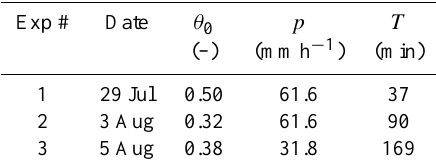
Table 2. Field test